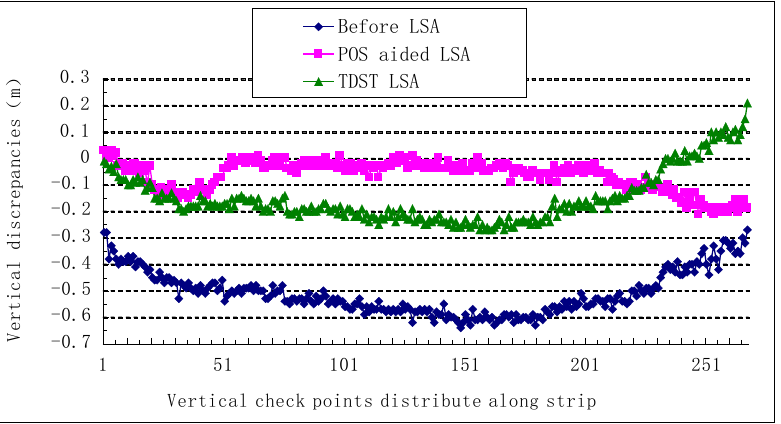
Figure 3. Discrepancies between Las1 and Las2 before and after LSA (In Fig. 3 and Fig. 4, the horizontal axis means the vertical check point selected along the flight direction on the LiDAR strips. The vertical axis presents the vertical discrepancies of the vertical check points between overlapping strips, and the unit is meter. The results demonstrated in blue, pink and green are the results before LSA, after using POS aided LSA and after using TDST LSA)